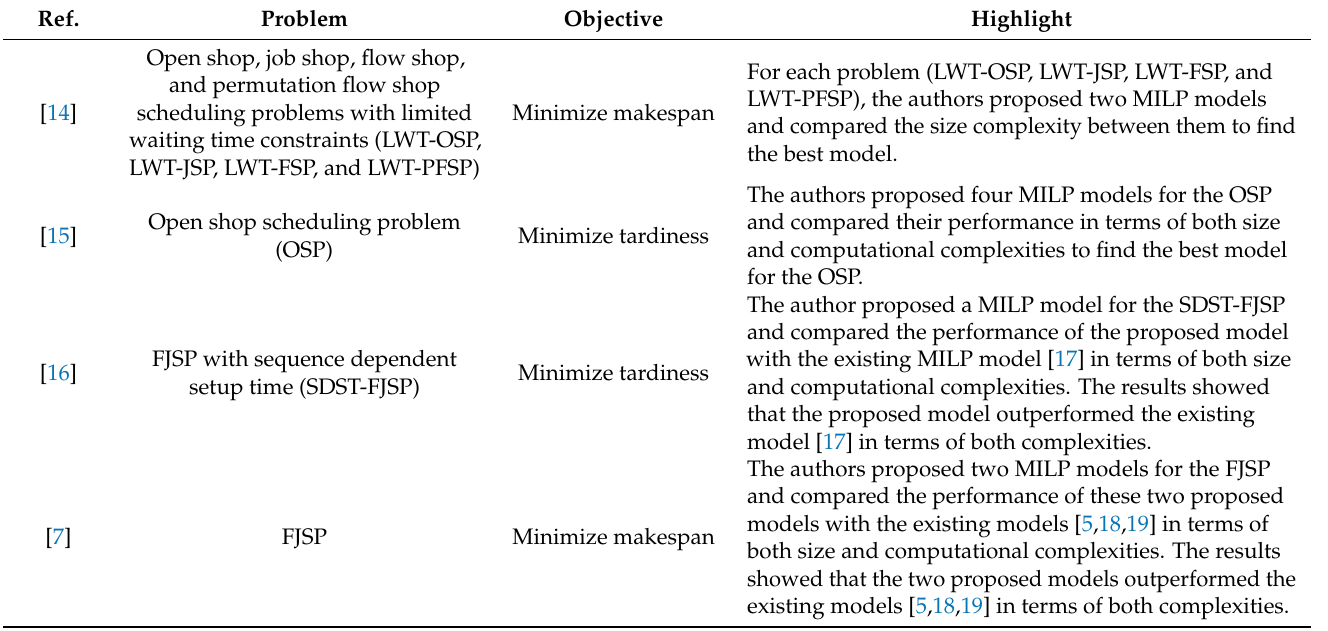
Table 1. Articles related to the comparison and improvement of MILP models of scheduling problems.